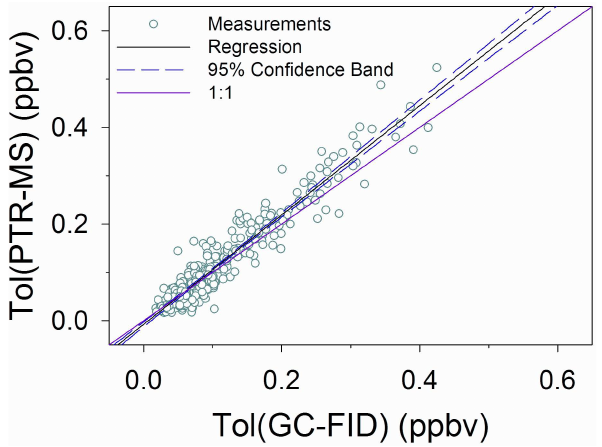
Fig. 7. Linear correlation between toluene measurements by GC- FID and PTR-MS. The regression line and its confidence band were derived from a simple least squares analysis. The regression param- eters are given in Table